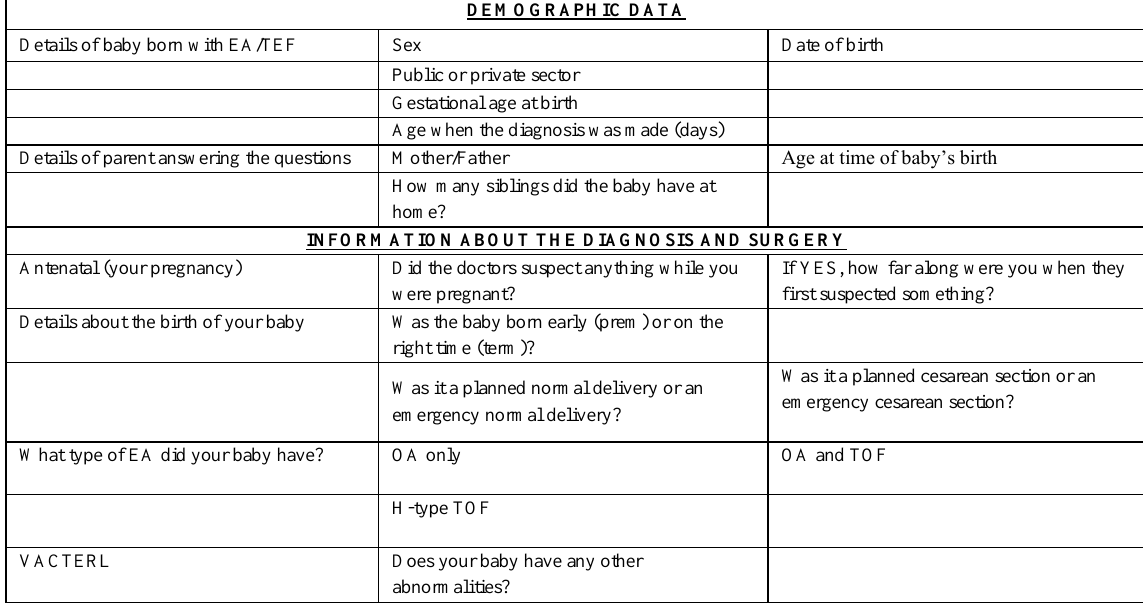
Table 1: Demographic data and general